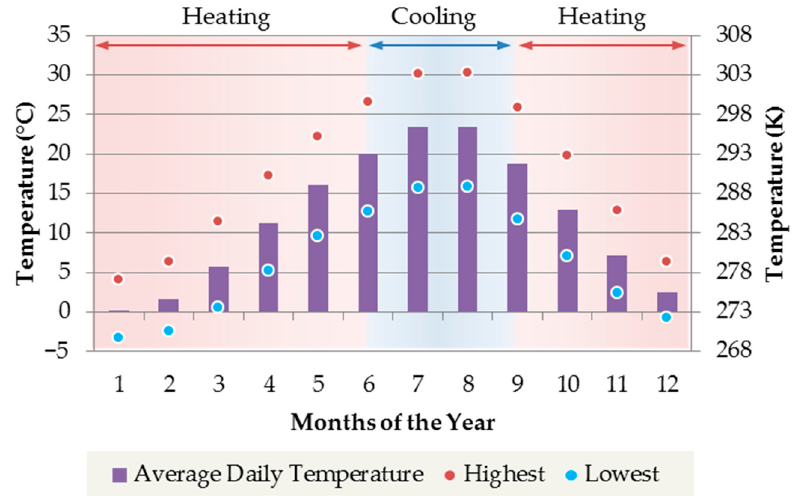
Figure 20. Annual Variation of Monthly Average Outdoor Dry-Bulb Temperatures in Ankara.